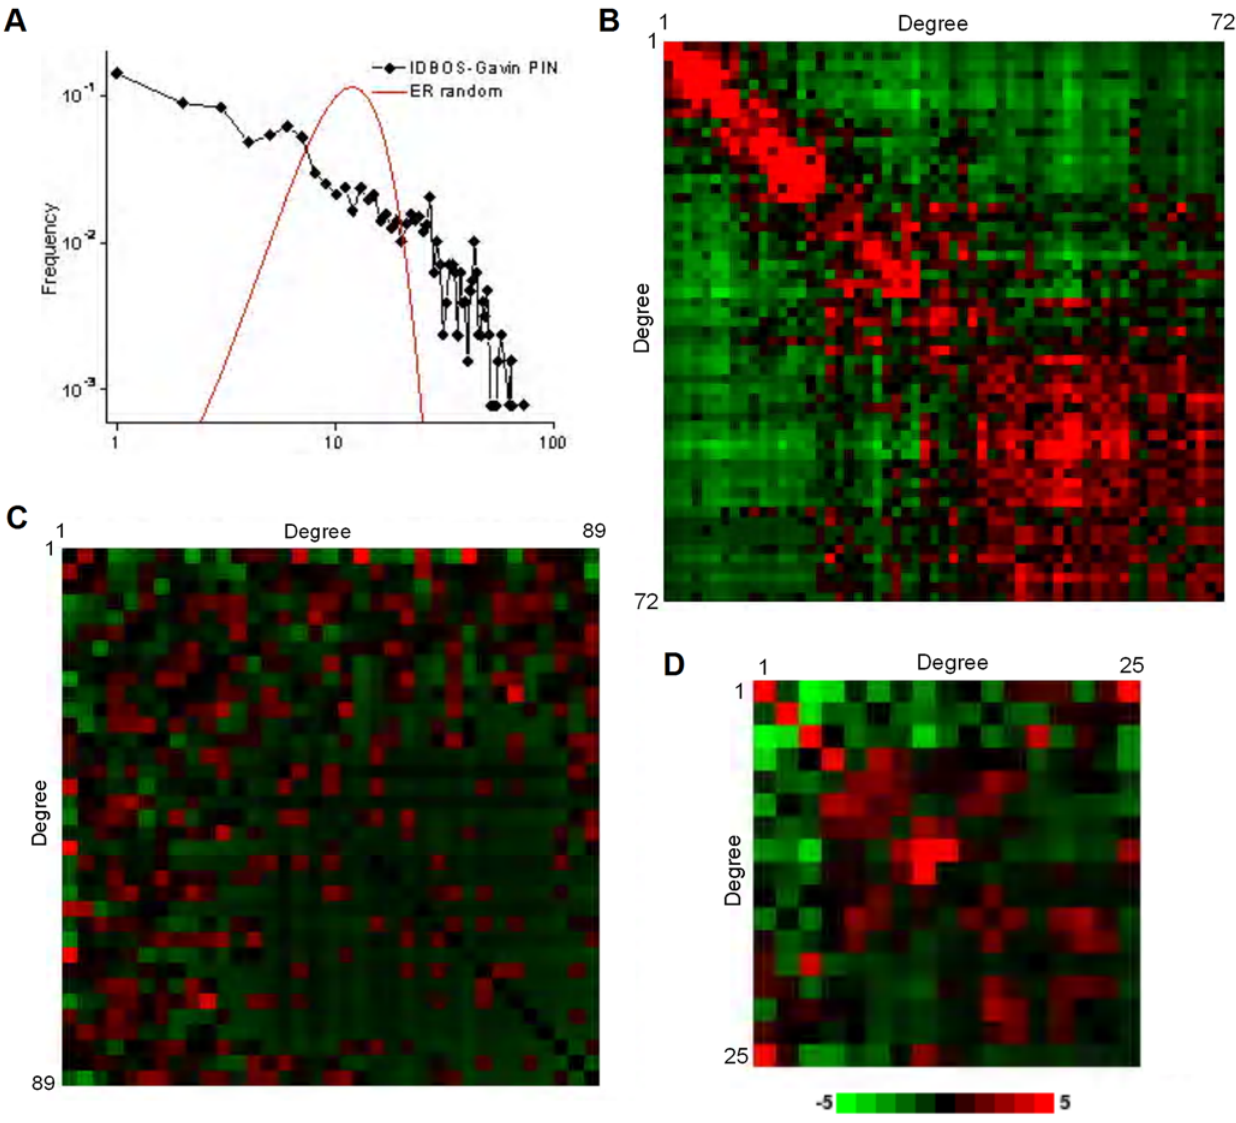
Figure 6. High-confidence AP/MS interaction data shows assortative mixing while Y2H interaction data shows disassortative mixing. (A) Power-law-like degree distribution of the IDBOS-Gavin PIN and for a commensurate completely random Erdo¨s-Re´nyi (ER) graph. Enrichments (Z-scores) of interaction frequencies, relative to commensurate, degree-preserving random networks (10 4 realizations) between pairs of degrees in the (B) IDBOS-Gavin PIN, (C) Y2H-union data set [6], and (D) BGS curated interaction set (see Materials and Methods). Most red indicates Z $ 5 (overrepresented) and most green indicates Z #2 5 (underrepresented).